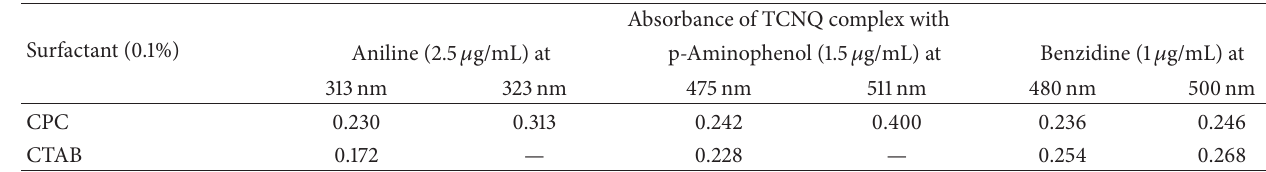
Table 2: Effect of surfactants on the absorption of aromatic amine-TCNQ complexes.